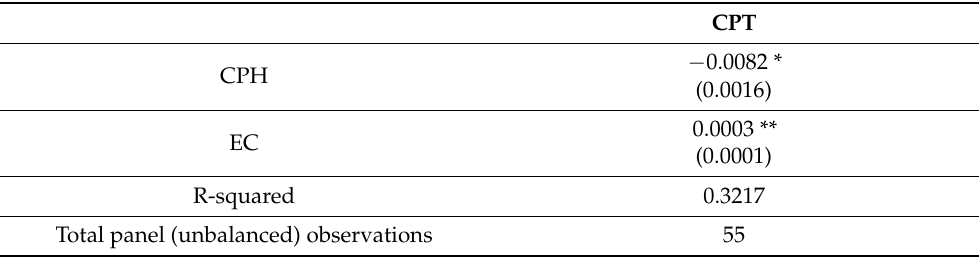
Table 5. Empirical results on a subsample formed by above average share of the time for a customer payment.